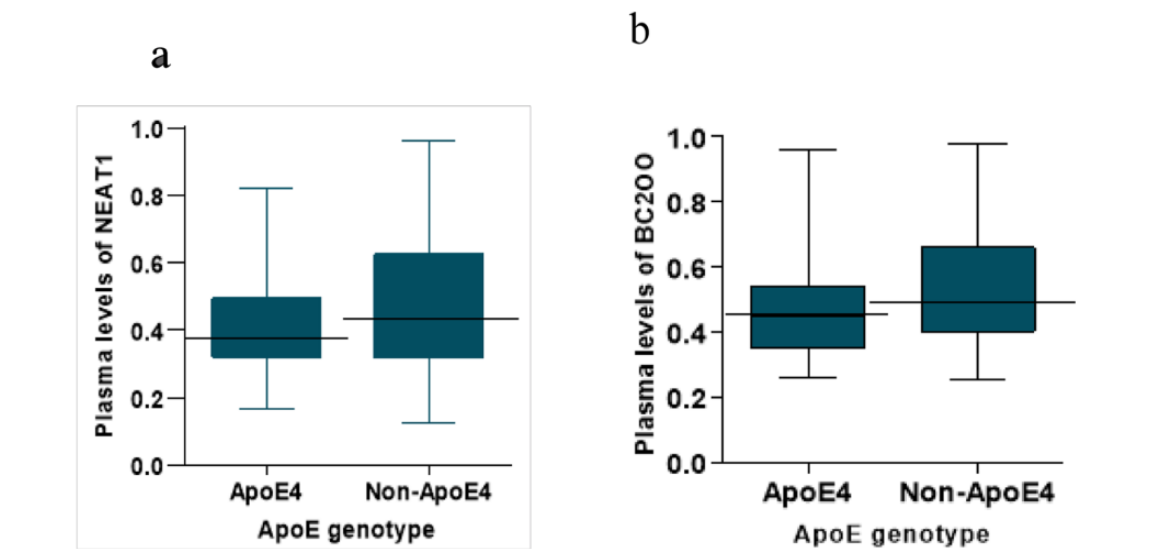
Figure 4: Effect of Apoε4 on the plasma levels of NEAT1 ( a ) and BC200 ( b ). The AD patients were scored as Apoε4 (with at least one Apoε4 allele) and non-Apoε4 (without Apoε4 allele), and the plasma levels of NEAT1 and BC200 were